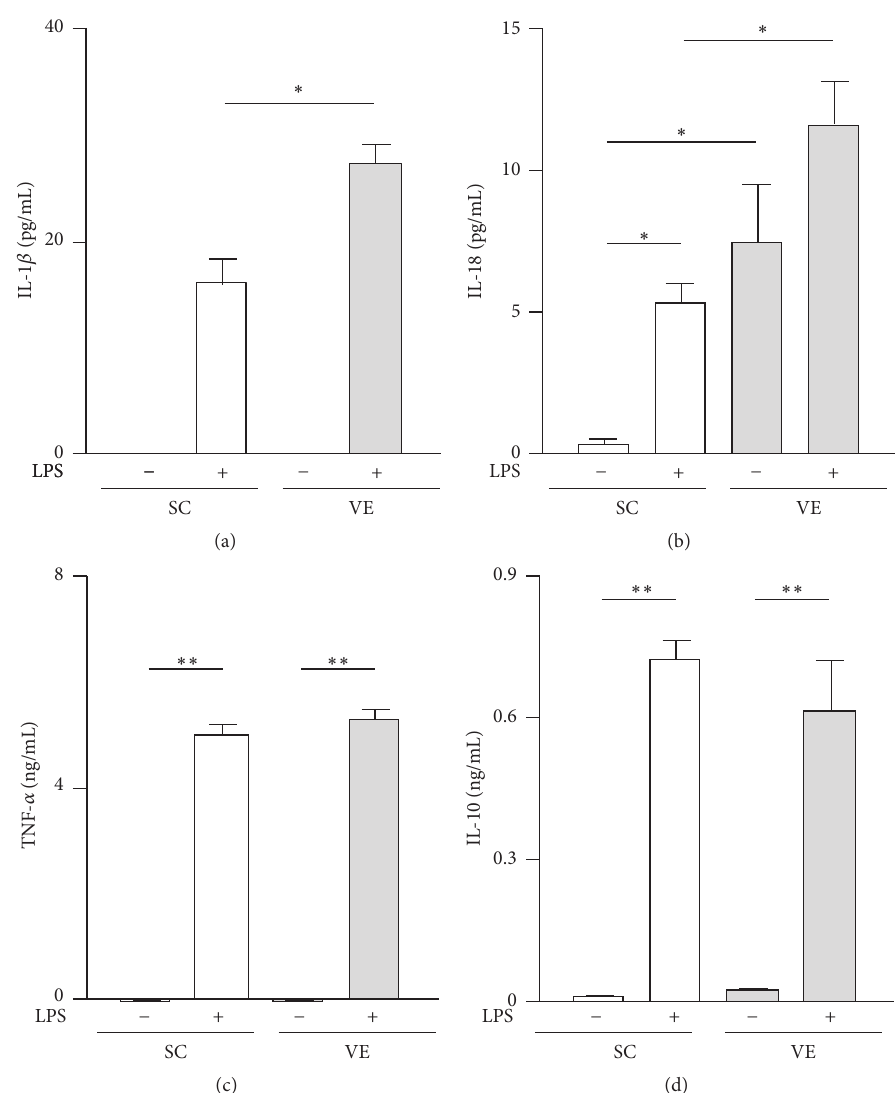
Figure 3: Effects of regular voluntary exercise (VE) on the secretion of pro- and anti-inflammatory cytokines from macrophages stimulated with or without lipopolysaccharide (LPS). Peritoneal-exudate macrophages isolated from the sedentary control (SC) and VE mice were cultured for 6 h in the presence or absence of 100 ng/mL LPS. Concentrations of interleukin- (IL-) 1 𝛽 (a), IL-18 (b), tumor necrosis factor- (TNF-) 𝛼 (c),andIL-10(d)inthecellculturesupernatantswerequantifiedbyenzyme-linkedimmunosorbentassay(ELISA).Mean ± standard error of the mean (SEM; 𝑛 = 4 ) values are provided. ∗ 𝑝 < 0.05 ; ∗∗ 𝑝 < 0.01 (by one-way analysis of variance [ANOVA] and the Bonferroni